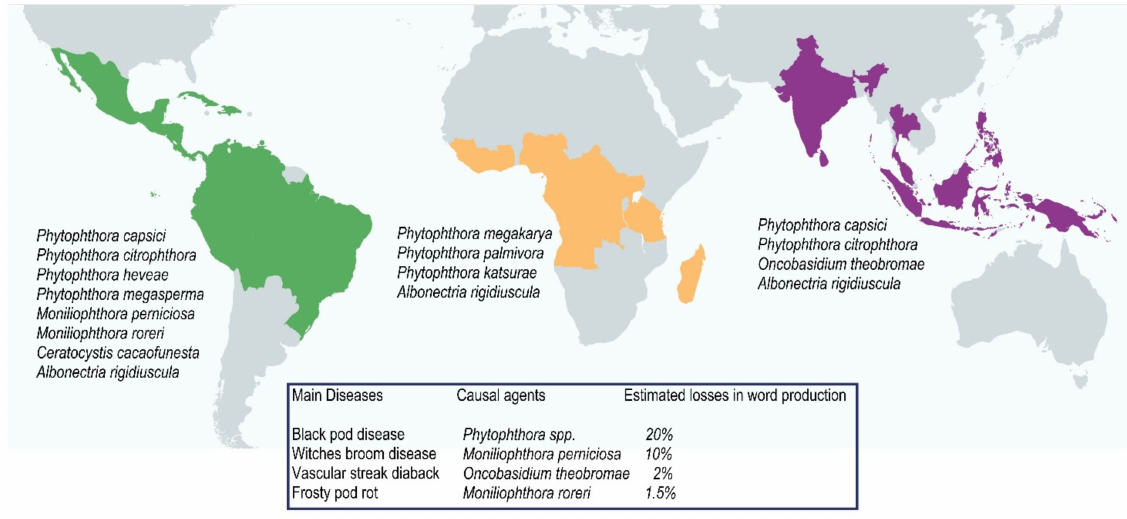
Figure 1. Main diseases in cocoa crops caused by fungi in the three cocoa-producing regions: America, Africa, and Asia and Oceania, related to the percentage of estimated losses in world cocoa production. Estimated values in secondary data